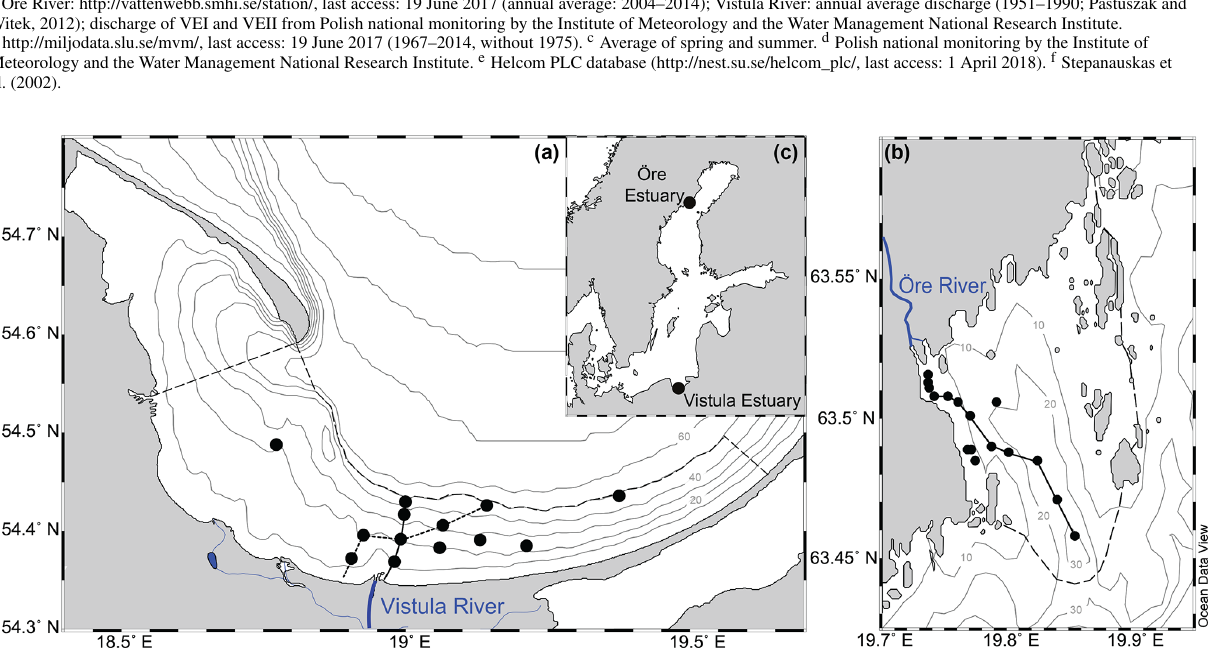
Figure 1. Map showing the locations of the Vistula Estuary (a) and Öre Estuary (b) in the Baltic Sea (c) . The boundaries of the estuaries are indicated by the dashed lines (see Sect. 2.1 for details). Lines along the station points represent the transects shown in Figs. 2 and 3. Vistula Estuary: VEI (solid line); VEII (dotted